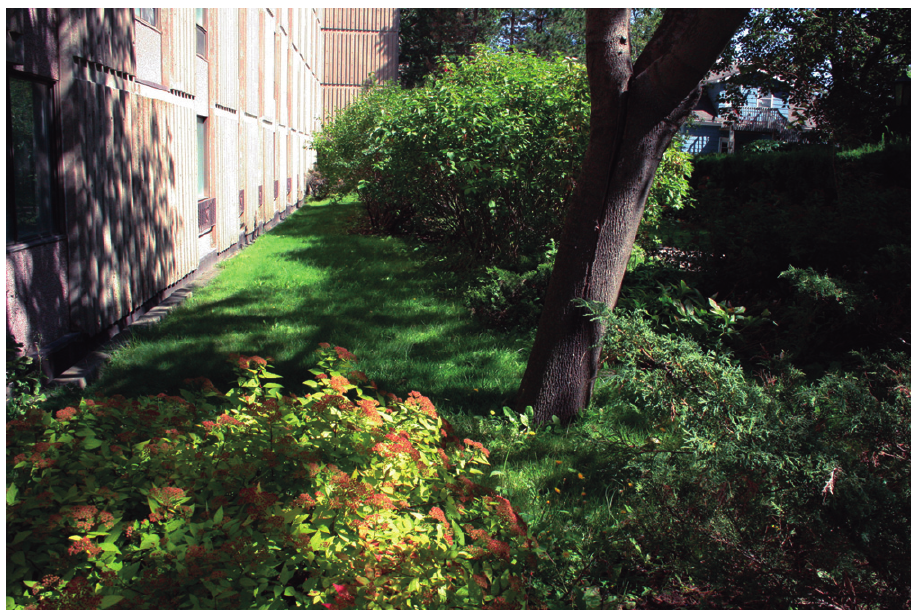
Figure 4. Photograph of the habitat at the Queen St. site where Phosphaenus hemipterus specimens were collected. Note the concrete wall of the apartment building directly abutting on the lawn area. In the foreground is the trunk of an ash tree, and a row of shrubs consisting of goldfl ame spiraea, fl y honeysuckle, red-ozier dogwood, and eastern redcedar. Photo credit: Christopher